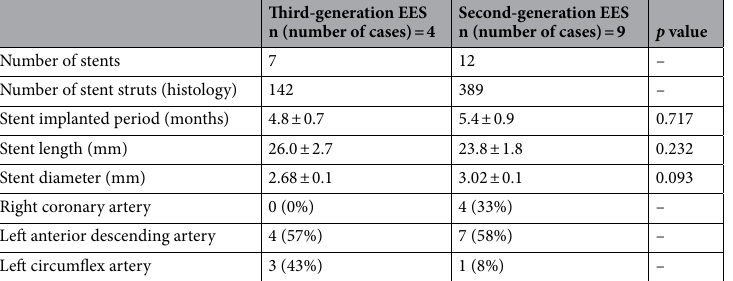
Table 1. Stent data of human autopsy